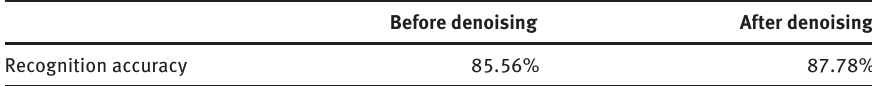
Table 3: Effect of Denoising on Recognition